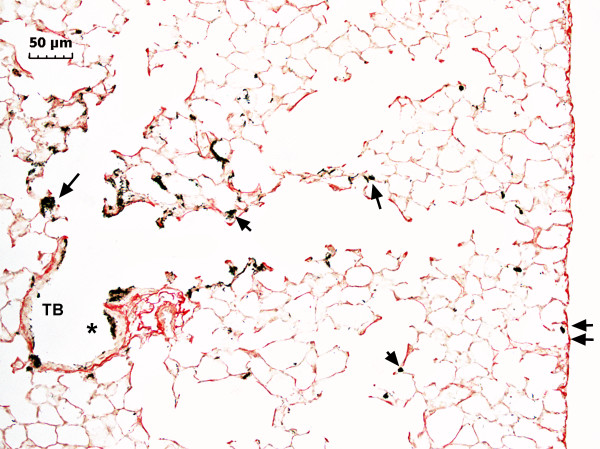
Light micrograph of MWCNT deposition in alveolar region of lungs. Sirius Red stained micrograph showing the general deposition pattern of MWCNT (arrows) one day after aspiration. A deposit of MWCNT on the epithelium of the terminal bronchiole (TB) near the transition between the airways and the alveolar region is indicated by the asterisk. Smaller deposits near the subpleural tissue region are indicated by double arrows. (dose 80 μg).